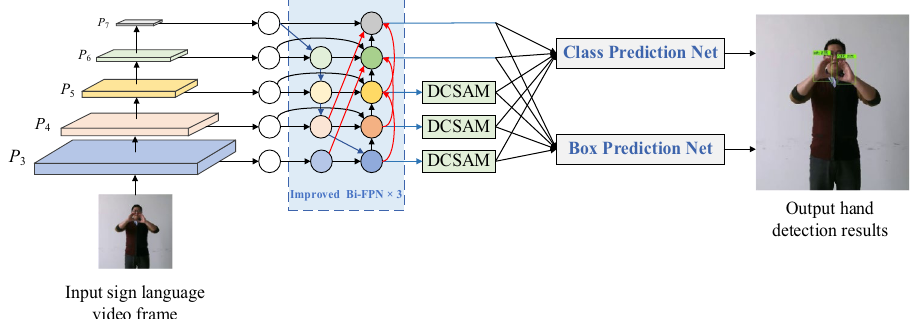
Figure 2. Framework of hand detection algorithm based on EfficientDet and integrating DCSAM attention.